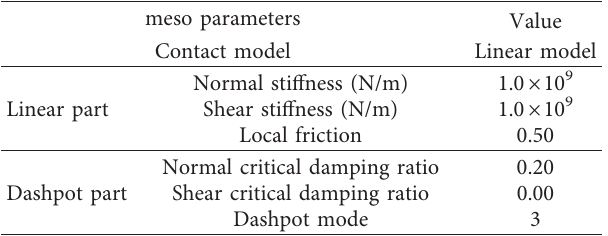
Table 7: Microproperties of linear contacts between rockfill particles.